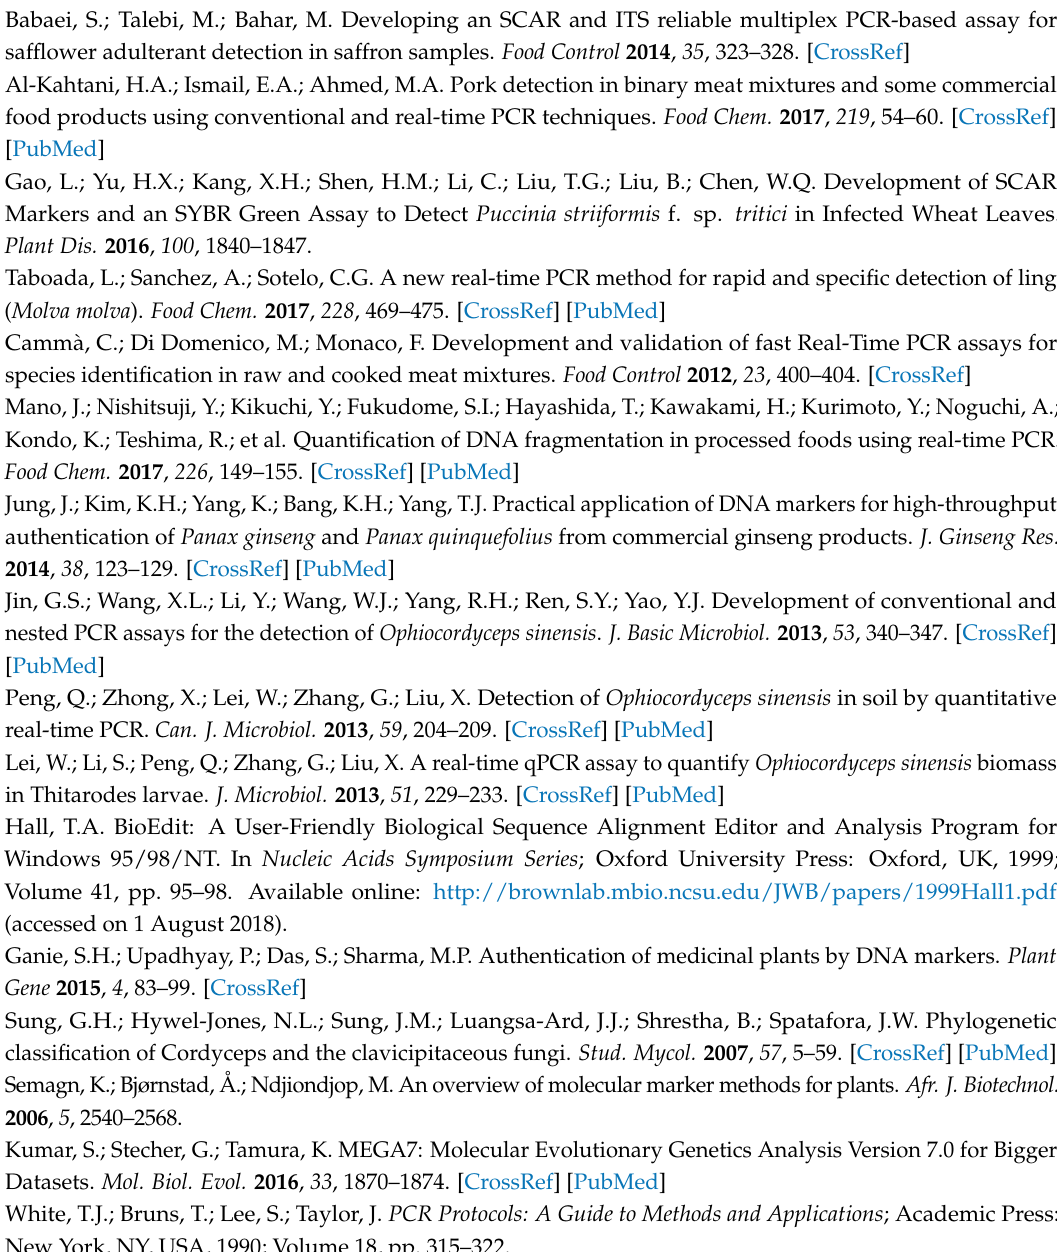
Sample Availability: Samples of the fungal strains are available from KACC and KCTC and commercial products are available from the authors and the herbarium of